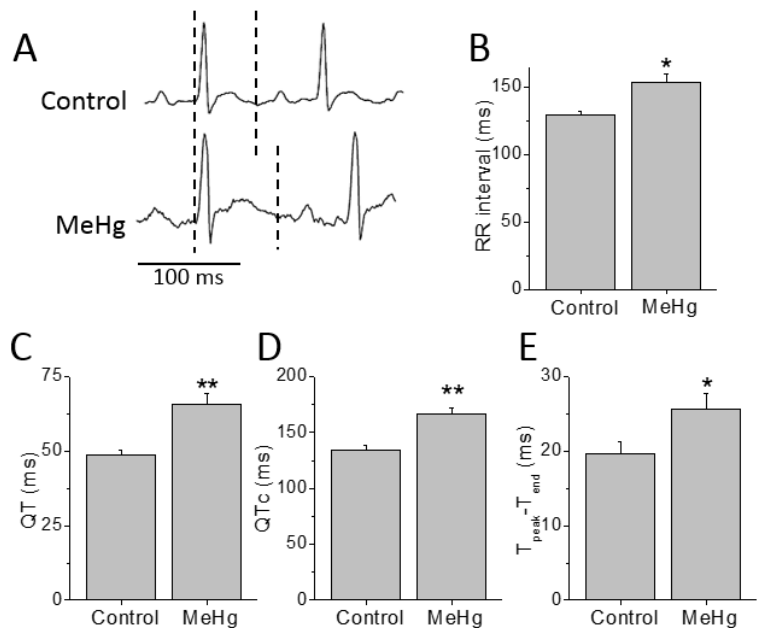
Figure 1. Chronic MeHg treatment prolongs cardiac repolarization in vivo. ( A ) Electrocardiograms of a conscious animal before and 4 weeks after treatment with MeHg 3 mg/kg·day (dashed lines show the QT interval). RR interval ( B ), QT interval, ( C ) heart rate corrected QT interval, QTc, ( D ) and repolarization dispersion, T peak –T end ( E ) were prolonged after MeHg treatment. n = 13 control and 15 MeHg-treated animals. * p < 0.05; ** p < 0.01.